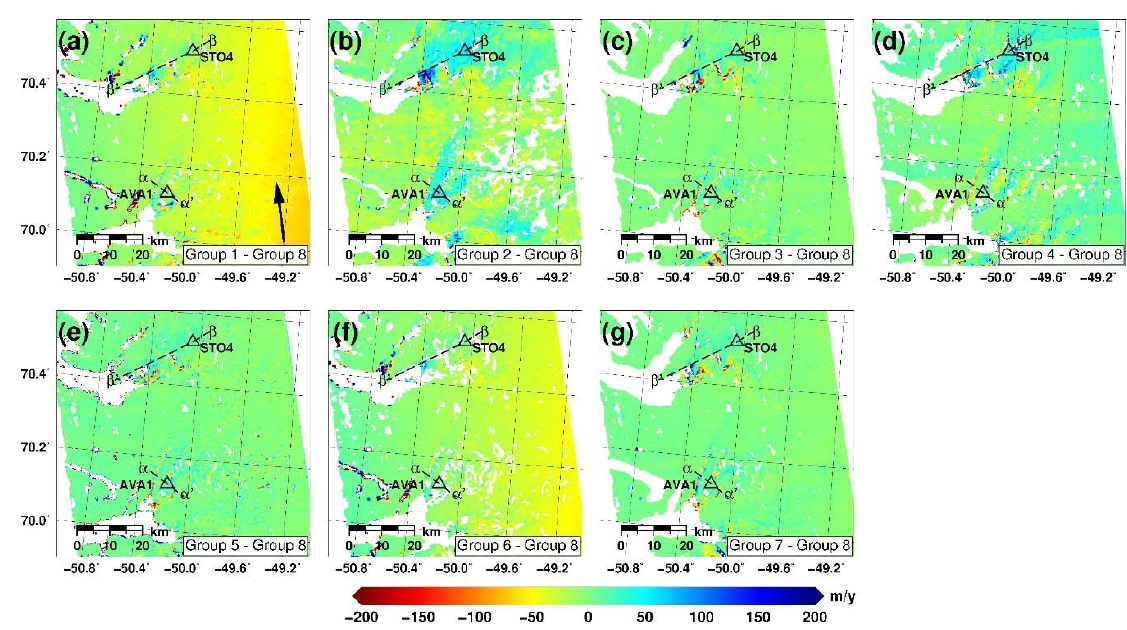
Figure 21. Task 4 azimuth velocity differences between groups 1 to 7 ( a – g ) and group 8 in the area of GPS stations STO4 and AVA1. The dashed lines represent the traces of the profiles in Figure 24b,d.